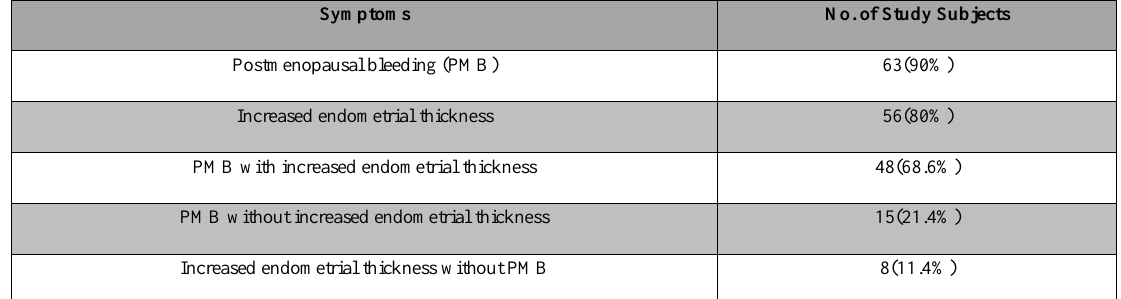
Table 1. Distribution of symptoms among the 70 study subjects.